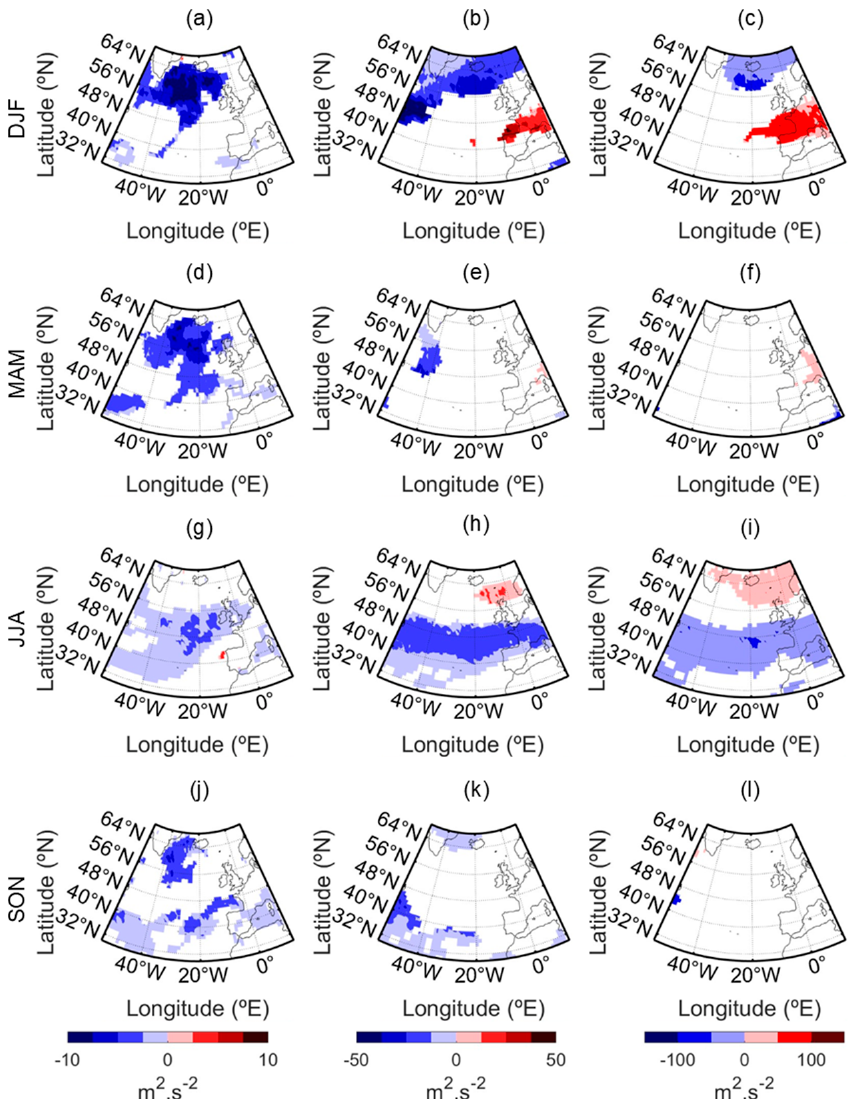
Figure 4. Absolute anomalies of the seasonal (winter: DJF, spring: MAM, summer: JJA, and autumn: SON) median KE (m 2 /s 2 ) for 2046–2065, relative to 1995–2014 (Figure 3), at 10 m (left column ( a , d , g , j )), 500 hPa (middle column ( b , e , h , k )) and 250 hPa (right column ( c , f , i , l )) levels, under SSP5-8.5. At the 10 m level, during all seasons, the anomalies are mostly negative and occur over the areas with higher KE in the reference period, in the Mediterranean and the Strait of Gibraltar. The negative anomalies at 10 m are stronger in winter and